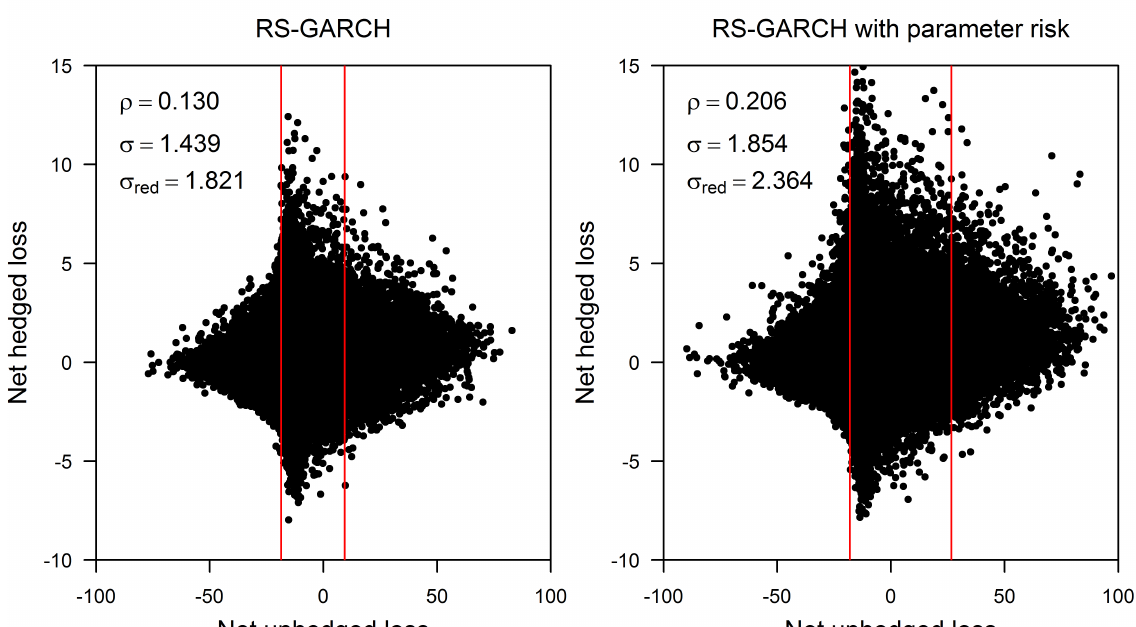
As expected, hedging errors are less dispersed in the tails of the distribution for the net un- hedged loss and the scatter plots are organized in a diamond. Figure 3 clearly illustrates the impact